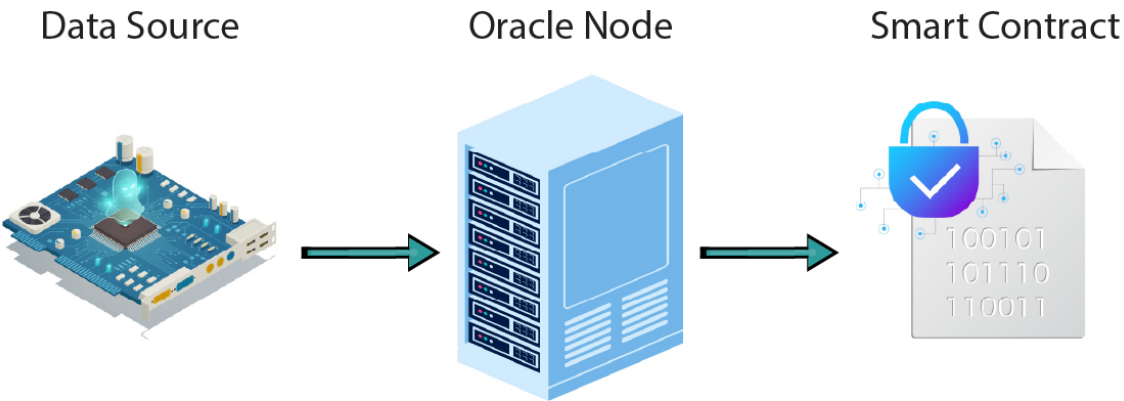
Figure 1. Oracle ecosystem.